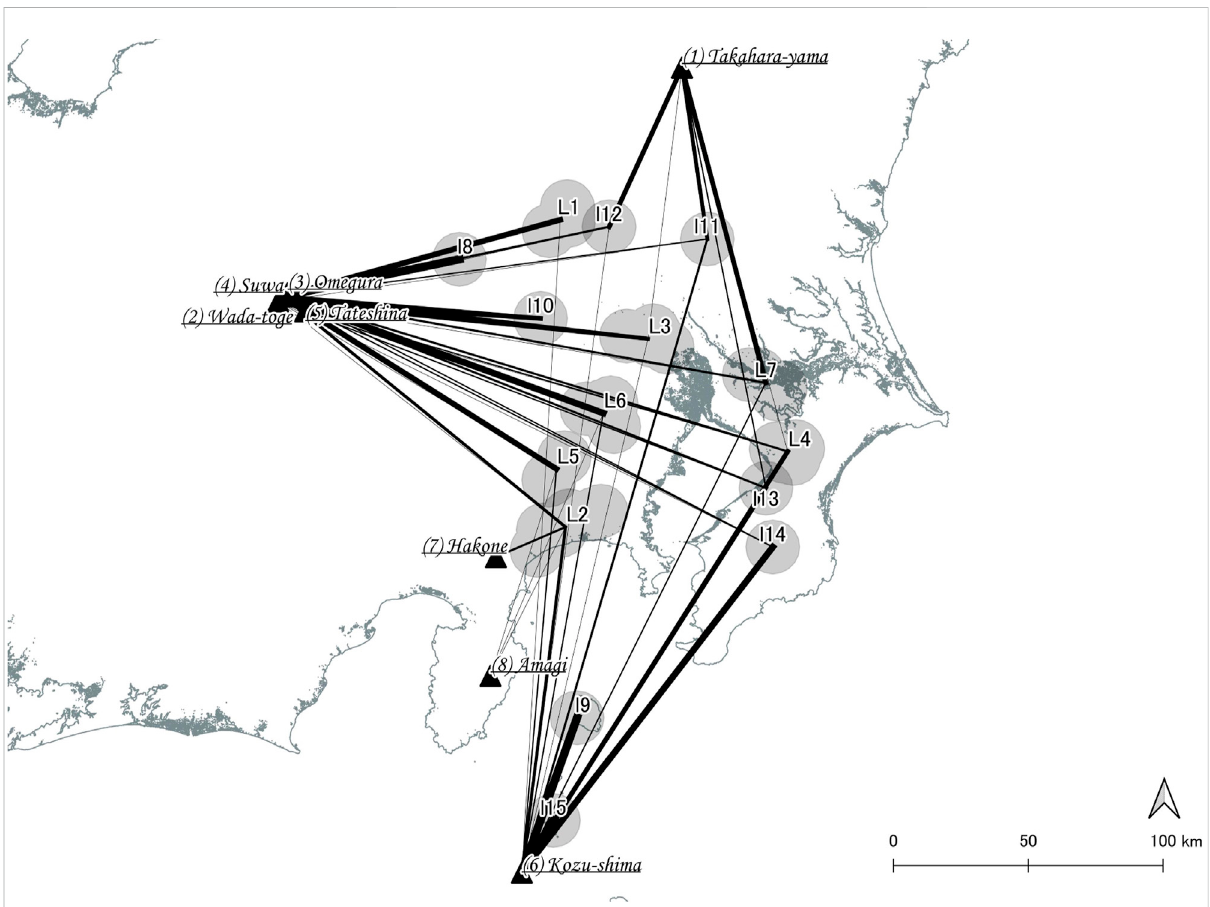
FIGURE 6 Bipartite graphs between provenance and consumption areas in Period 4, the late Jomon period (4,500 – 3,200 years cal BP). Clusters are represented by uppercase characters and single sites by lowercase characters. The thickness of the links corresponds to the composition ratio of each production area in each cluster (L1 – 7) and each single site (l8 –